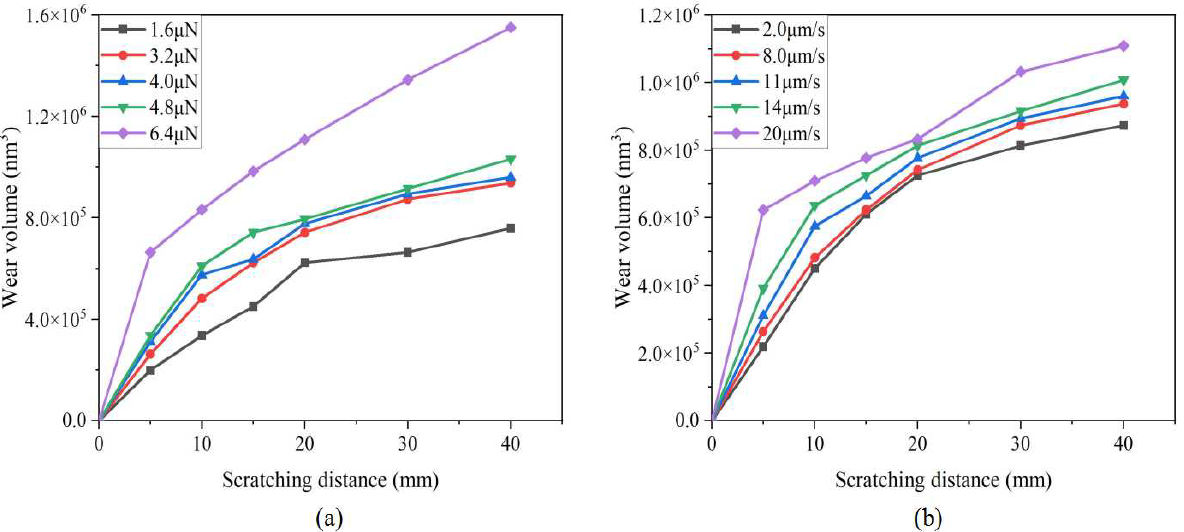
Figure 7. Relationship between scratching distance and probe wear volume: ( a ) different normal load levels; ( b ) different scratching speed levels .